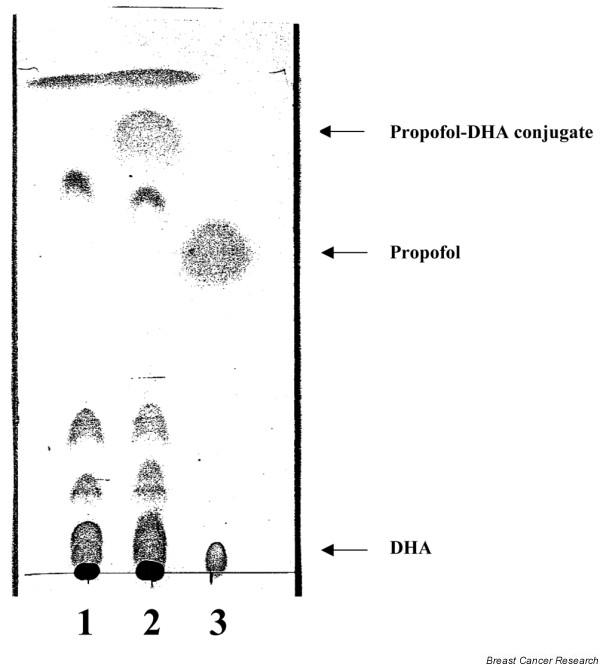
Thin-layer chromatography (TLC) analysis of propofol-docosahexaenoic acid (propofol-DHA) conjugate synthesis. Synthesis of propofol-DHA was performed as described in the text. The product of the reaction was separated by TLC with a light petroleum (38.3–53.2°C)/ethyl ether (98:2, v/v) solvent system and the products were revealed with iodine vapors. Lane 1, product of the reaction mixture that contained all starting material except propofol; lane 2, product of the complete reaction mixture; lane 3, propofol and DHA standards.